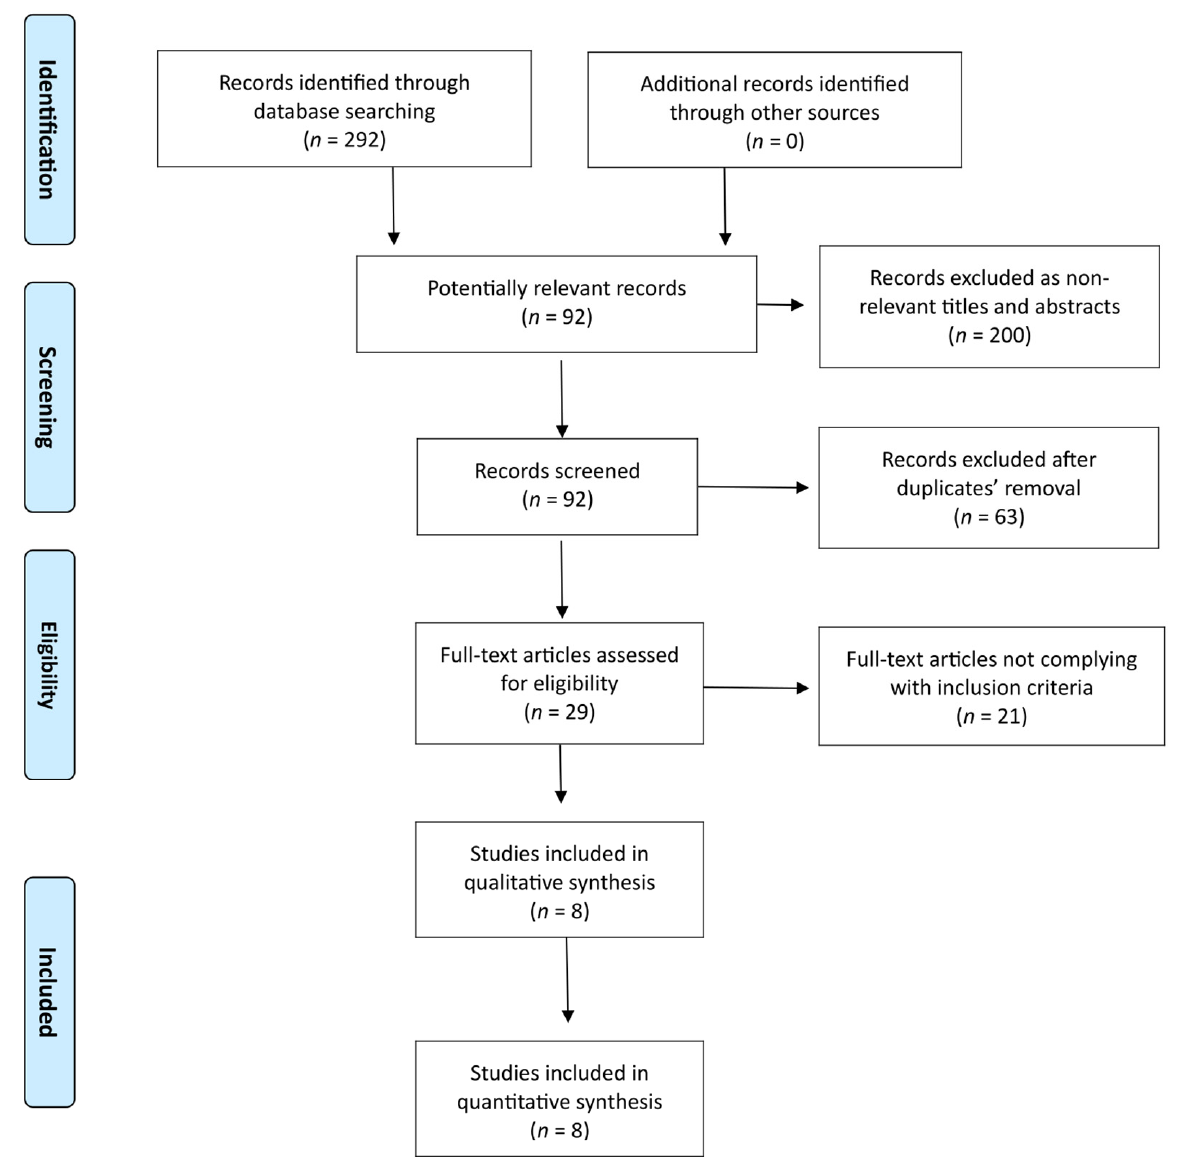
Figure 1. PRISMA flow chart of literature search.